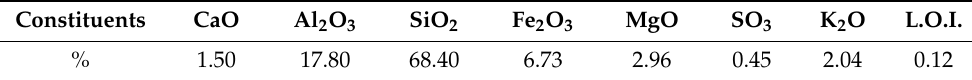
Table 2. Chemical composition of the clay.